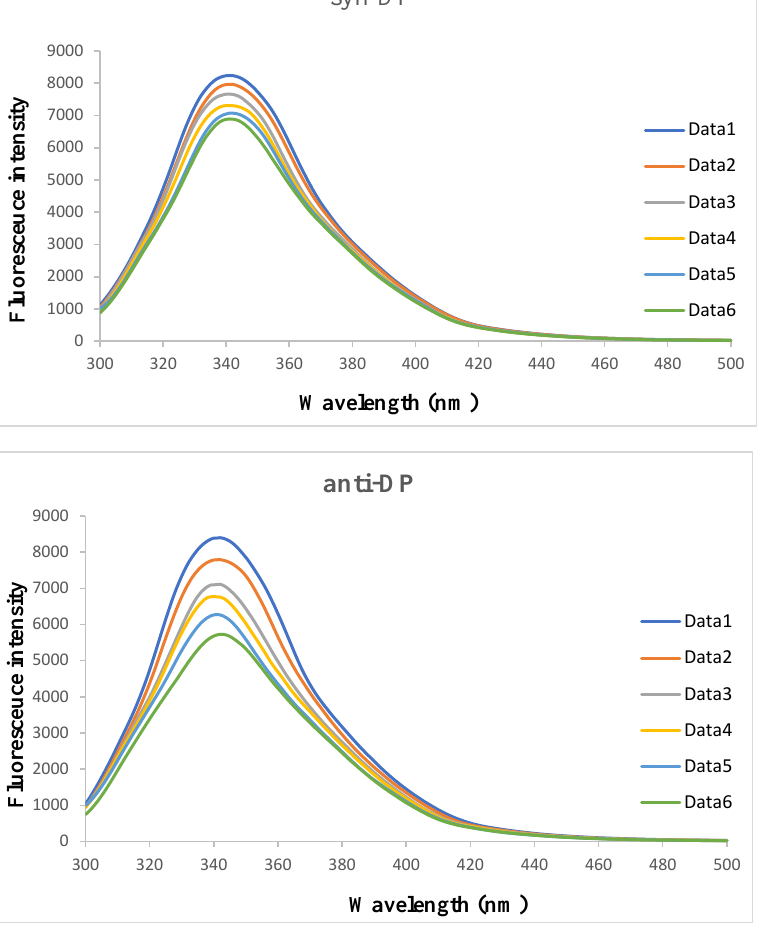
Figure 2. Fluorescence quenching curves for sheep serum albumin in the presence of syn-Dechlorane plus (DP) and anti-DP at room temperature (Data1, Data2, Data3, Data4, Data5, and Data6 are for DP concentrations of 0, 2 × 10 − 7 , 4 × 10 − 7 , 6 × 10 − 7 , 8 × 10 − 7 , and 10 × 10 − 7 mol/L, respectively). Yang et al. [18] studied interactions between Matrine and human SA and bovine SA and found that endogenous fluorescence of SA was mainly caused by phenylalanine, tryptophan, and tyrosine residues. The fluorescence intensity of phenylalanine residues near 284 nm was found to be weakest, the fluorescence intensity of tyrosine residues near 304 nm was next weakest, and the fluorescence intensity of tryptophan residues near 335 nm was found to be strongest. Matrine interacts with human SA and bovine SA to form a complex in the ground state. Formation of the complex quenches human SA and bovine SA fluorescence. Figure 2 shows that there was a strong fluorescence emission peak at 341 nm when SSA was in the presence of anti- or syn-DP. This indicated that fluorescence quenching may occur when anti- or syn-DP combines with tryptophan in SSA. The fluorescence intensity of the SSA gradually decreased as the DP